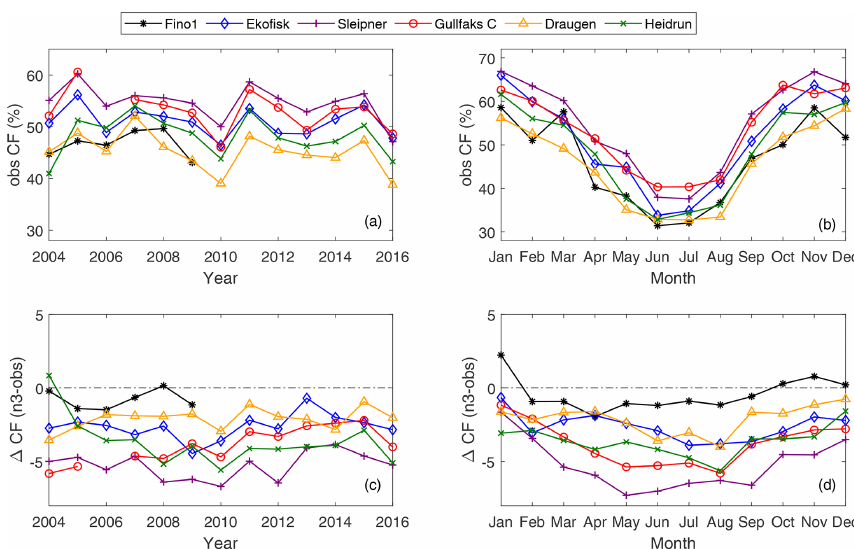
Figure 7. (a) The observed inter-annual variation in the capacity factor (obs CF). (b) Seasonal variation in CF for the observations. (c) The difference in the inter-annual CF ( (cid:49) CF) between the model and the observations (n3 − obs). (d) The difference in the seasonal CF between the model and the observations (n3 − obs). A specific year was excluded from the plot if more than one-half of the data for that year were missing.